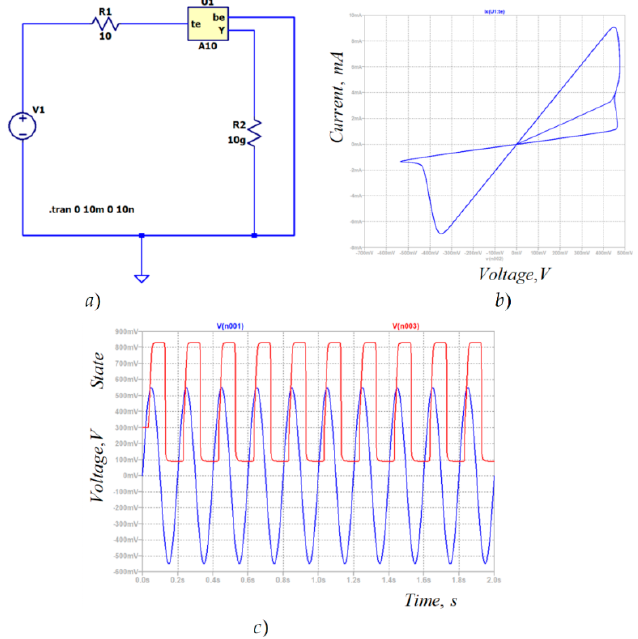
Figure 7. ( a ) A simple circuit for testing the memristor model in LTSPICE; ( b ) Time diagrams of the memristor voltage and state variable according to the tantalum oxide memristor models; ( c ) Corresponding current–voltage characteristics.